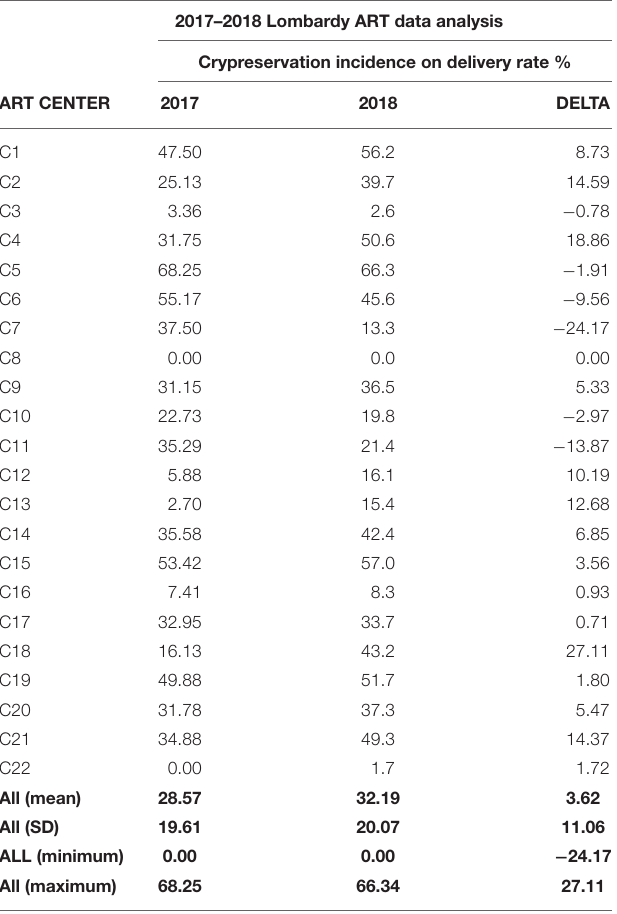
TABLE 5 | Cryopreservation incidence on cumulative delivery RATE % in all 22 IVF centers in the period 2017–2018.